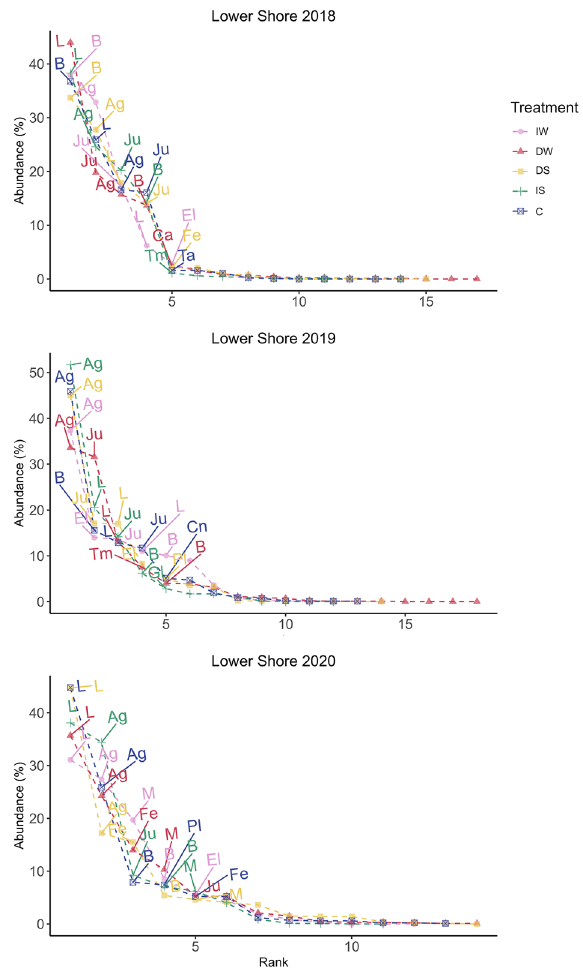
Figure 3. Rank abundance curve of the Lower Shore community. Mean abundance as percentage cover (n = 3) for August is on the y-axis, while species are ranked consecutively on the x-axis. B Bare gound, Ag Agrostis stolonifera , Ju Juncus gerardii , El Eleocharis palustris , Pl Plantago maritima , Fe Festuca rubra , Tm Triglochin maritima , L Litter; Ca Carex nigra , Gl Glaux maritima , M Moss, Cn Cnidium dubium . Pink: increased water level (IW); red: decreased water level (DW); yellow: decreased salinity (DS); green: increased salinity (IS); blue: control